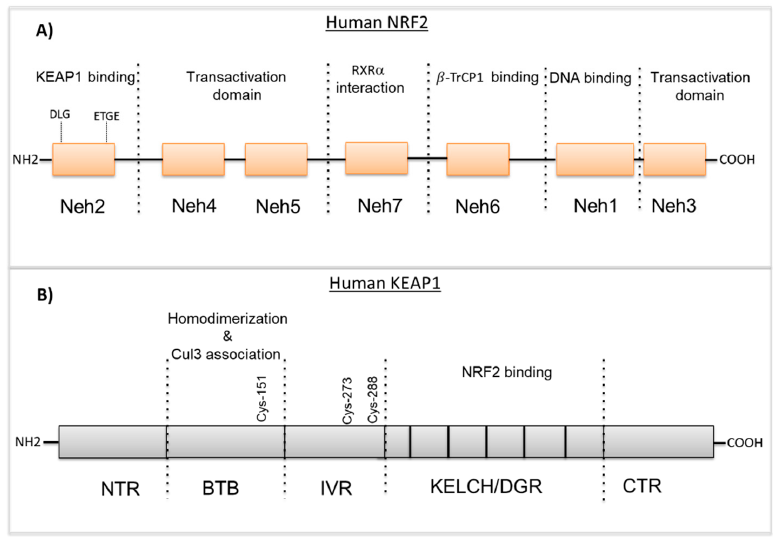
Figure 1. The structures of NRF2 and KEAP1. ( A ) NRF2 includes seven highly conserved domains Neh1–Neh7. The N-terminal Neh2 domain contains DLG and ETGE motifs that control the KEAP1 interaction. The Neh3, Neh4, and Neh5 domains are called transactivation domains. The Neh7 domain is required for the interaction with the Retinoid X receptor- α . The Neh6 domain is a serine-rich domain that binds to β -TrCP. The C-terminal domain, Neh1, is responsible for DNA-binding and hetero-dimerization with small MAF proteins (sMAFs). ( B ) KEAP1 contains five domains. The BTB domain mediates KEAP1 homodimerization and Cul3-E3-ligase binding. The IVR contains critical reactive cysteine residues that are essential for controlling the NRF2 activity. The Kelch/DGR domain is required for interaction with the Neh2 domain of NRF2. BTB, broad complex, tram-track and bric-a-brac; CTR, C-terminal region; Cul3, Cullin3; IVR, intervening region; KEAP1, kelch-like ECH-associated protein 1; sMAFs, musculoaponeurotic fibrosarcoma oncogene; Neh, NRF2–ECH homologous structure; NRF2, nuclear factor erythroid-2-related factor-2; NTR, N-terminal region; RXR α .